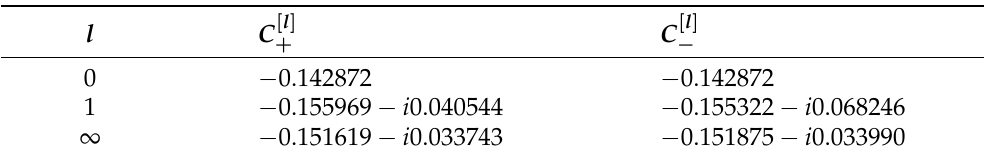
Table 1. Expansion coefficients of free solutions in the unperturbed potential for the first two iterations and for the exact solution ( l = ∞